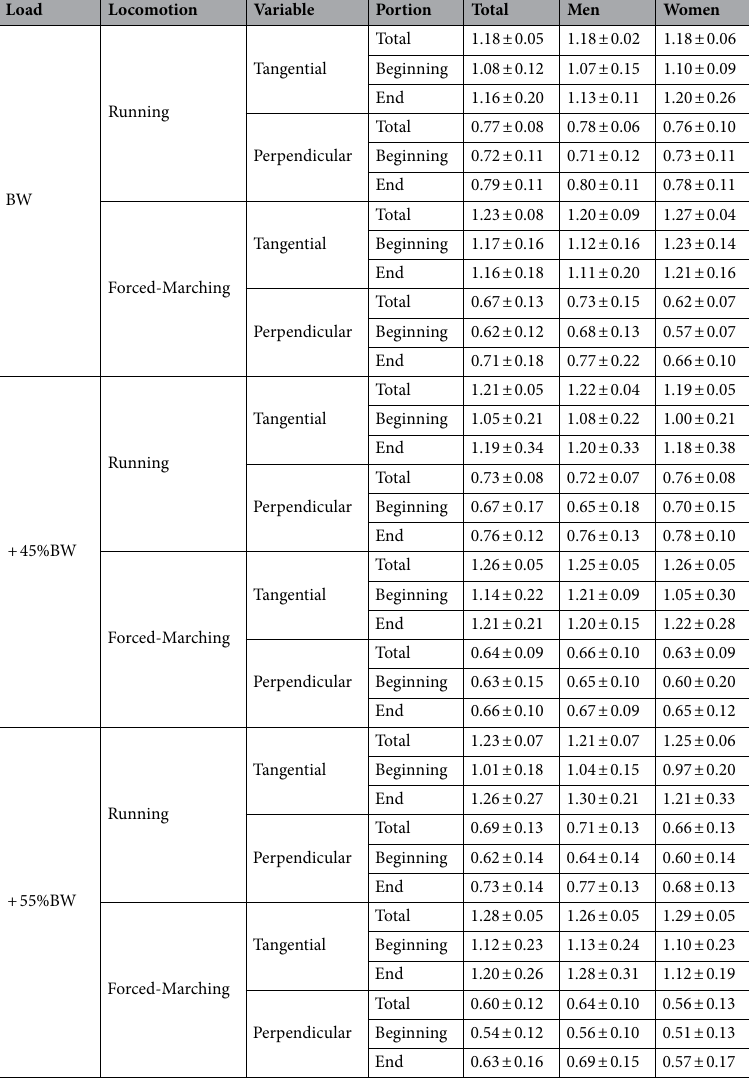
and forced-marching, individuals from the present sample exhibited optimal spatiotemporal complexity (stride time and stride length α = 0.75–1.00 [Table 6]), relative variability > 1.0 (Table 3), leveraged null space variabil- ity (greater tangential variability compared to perpendicular variability) (Table 4), minimally controlled null space motor solutions (α≈1.0) and tightly controlled task space motor solutions (α ≈ 0.5) (Table 5) with limited meaningful differences between sexes. These findings suggest that this sample population execute state-space exploratory behavior primarily to execute the task goal, but the greater relative variability during the loaded forced-marching conditions may be pursued at the expense of deleterious cost functions and potentially increase MSI risk (see Fig. 2). Thus, careful examination of the confluence of findings, may however reveal important discriminations, which need to be considered further, especially when generalizing from the dimensionally limited confines of the laboratory to a more dimensionally rich, real-world setting. Previous load carriage research 4 , observed relative variability and spatiotemporal complexity decreased with